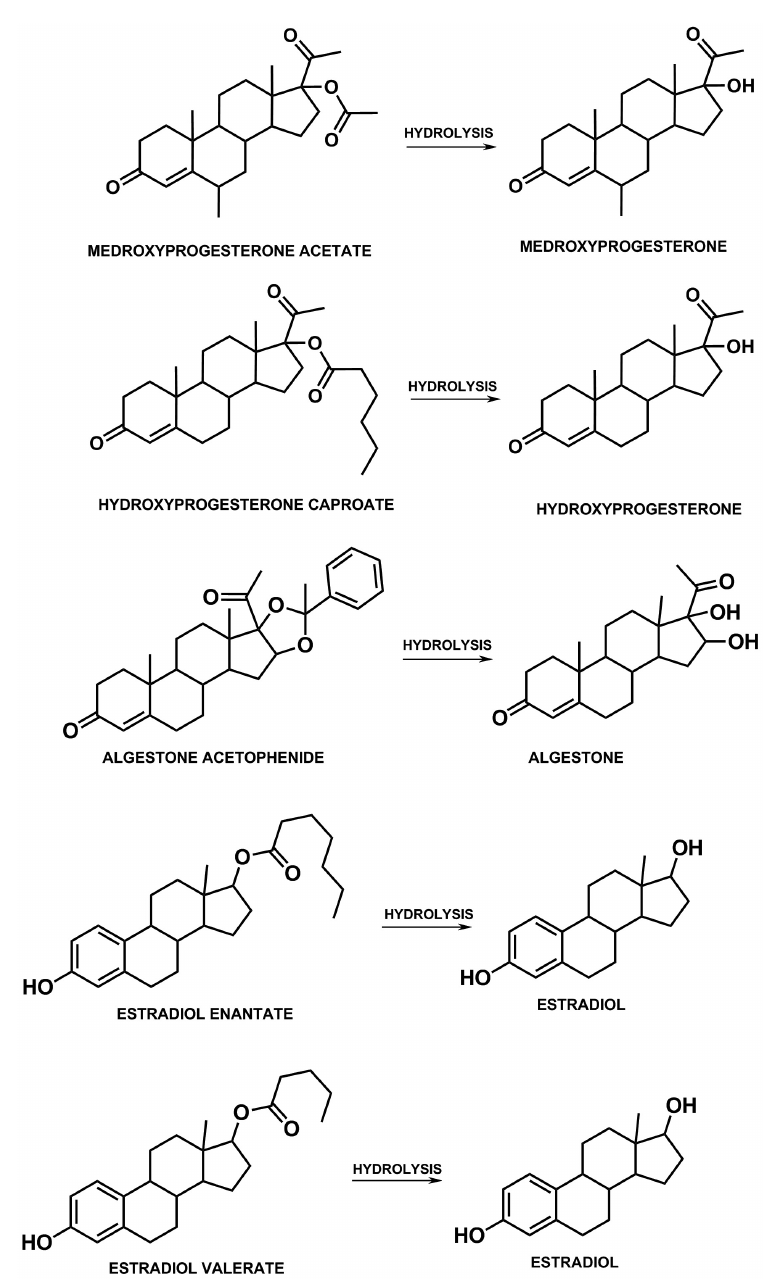
FIGURE 27 - The main sexual hormones available on the market and their bioactivation. ded for the treatment of ocular hypertension in open- Figure 28, through hydrolytic and oxidation metabolic angle chronic glaucoma, and it functions by reducing the conversion, in order to form terbutaline. The maximum production of aqueous humor (Carneiro França, 2008). plasmatic concentration (C ) of the active metabolite max Dipivefrin is a prodrug of epinephrin obtained from the (terbutaline) is reached in approximately 2-6 hours and it sterification of the catecholic hydroxyl groups present in lasts at least 24 hours (Rautio et al. , 2008; Rosenborg et epinephrin with pivalic acid. This sterification leads to an al. , 2001; Testa, 2004; Tunek, Svensson, 1988). increase in lipophilicity and as a consequence, this prodrug is capable of permeating the corneal extract 17 times faster Antiglaucoma agents than epinephrin. After absorption, hydrolysis of the Dipivefrin, derived from epinephrin is recommen-